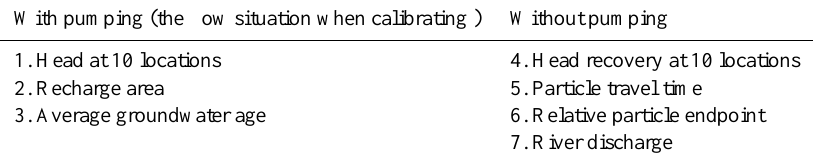
Table 3. Different types of model predictions with and without a pumping well. With pumping (the flow situation when calibrating ) Without pumping